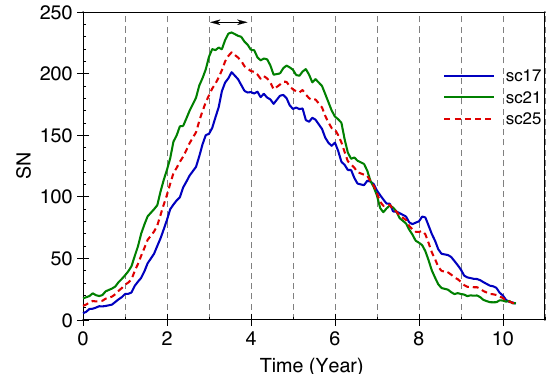
Fig. 4. Comparison between SC 17 and SC 21 by using a 12 Bartels- running mean values. The trend of SC 25 is derived as the average values of SCs 17 and 21. The maximum is expected between 3 and 4 years after the cycle onset (black